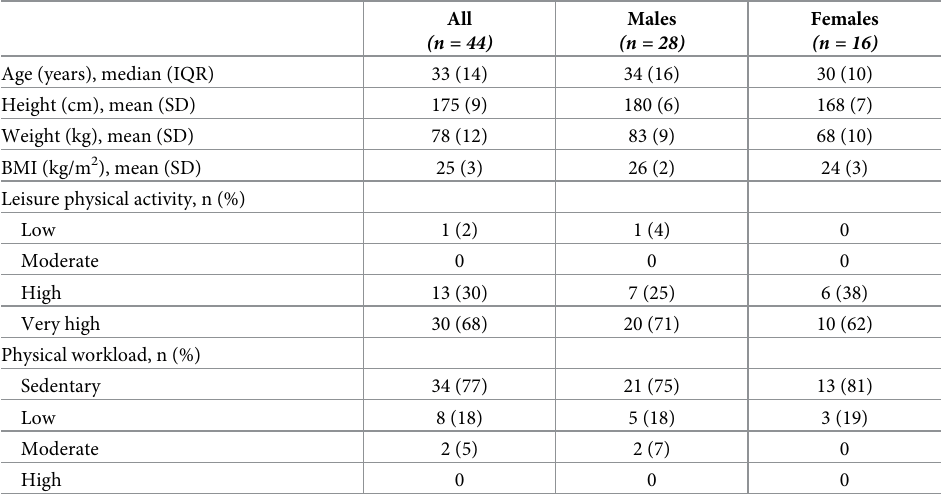
Fig 1. An IsoKai isokinetic lift test and the corresponding force curve expressed as Newton per cm of the lift. https://doi.org/10.1371/journal.pone.0207054.g001 Table 1. Characteristics of the study